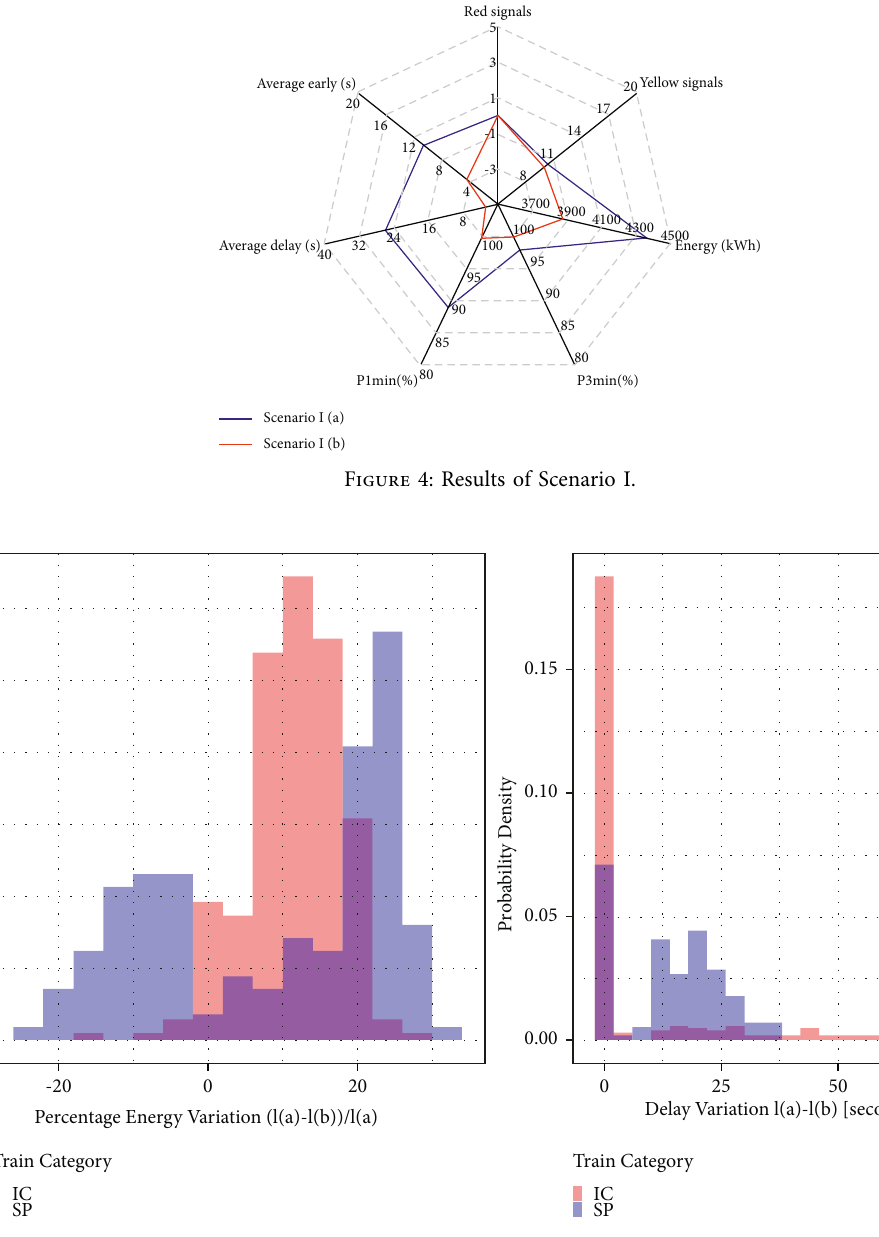
Figure 5: Analysis of Scenario I by energy/delays, based on train